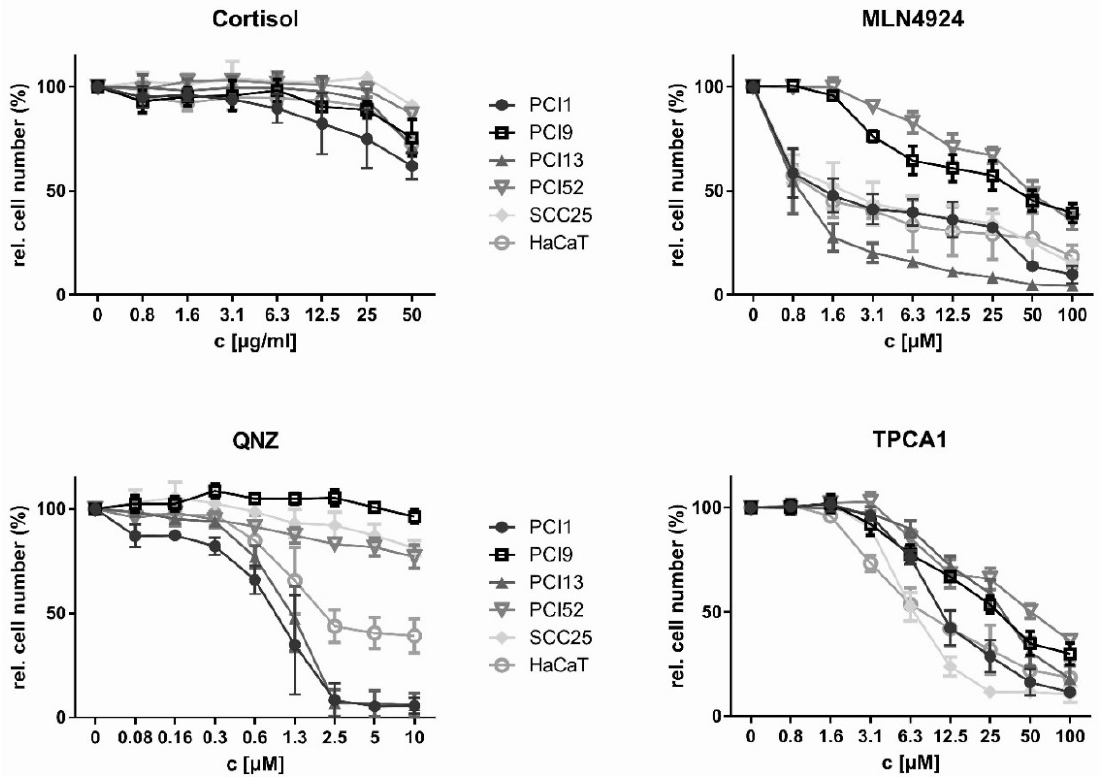
Figure 2. Inhibition of proliferation by Cortisol, MLN4924, QNZ and TPCA1 in HNSCC cell lines. Cells (1 × 10 4 /well) were stimulated for 72 h with the indicated concentrations of Cortisol, MLN4924, QNZ and TPCA1. The RCN was determined via crystal violet staining and normalised to that of the untreated control (100%). Mean values of the experiments reproduced at three independent time points ( n = 3) are shown. For efficacy evaluation, the IC 50 was determined for each NF κ B inhibitor and cell line.